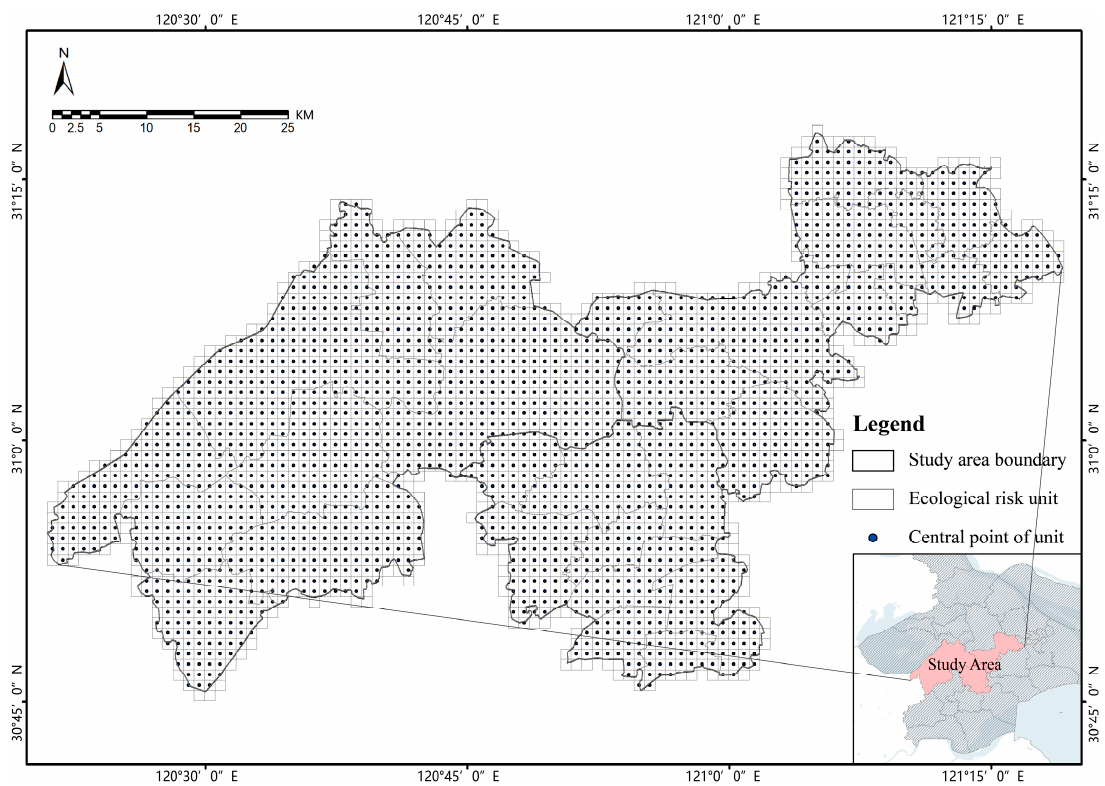
Figure 3. Square sampling grid of 1 km × 1 km in the demonstration area.